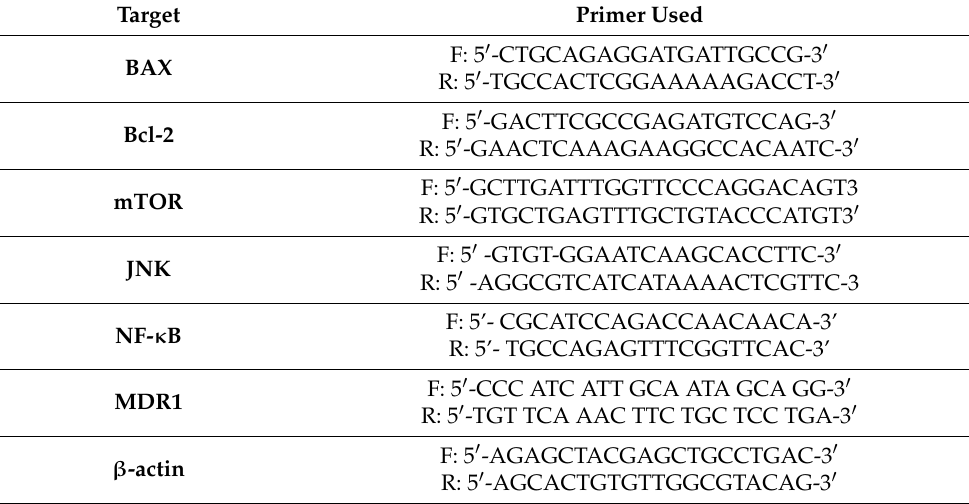
Table 1. The primer used in the